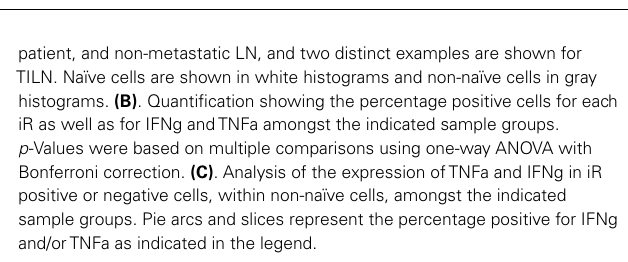
Table 1 | Summary on the expression of iRs and its link to cytokine production in CD8T cells, considering differentiation, activation, and anatomical location